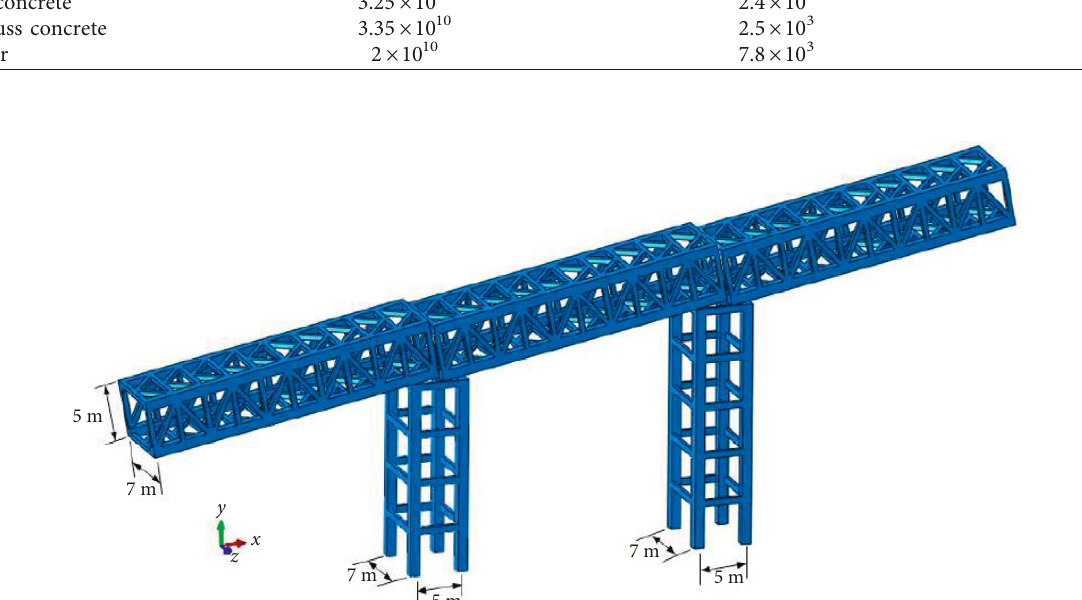
Figure 3: The 3D model of coal conveying trestle.